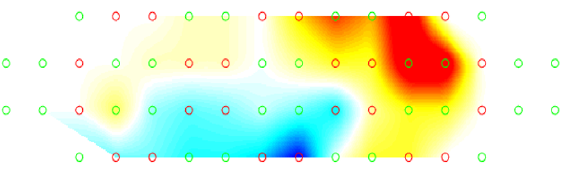
Figure 8. Frame from Activation Map Video Showing Changes in